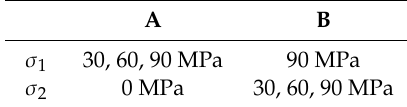
Table 2. Two groups of applied stress setting for numerical